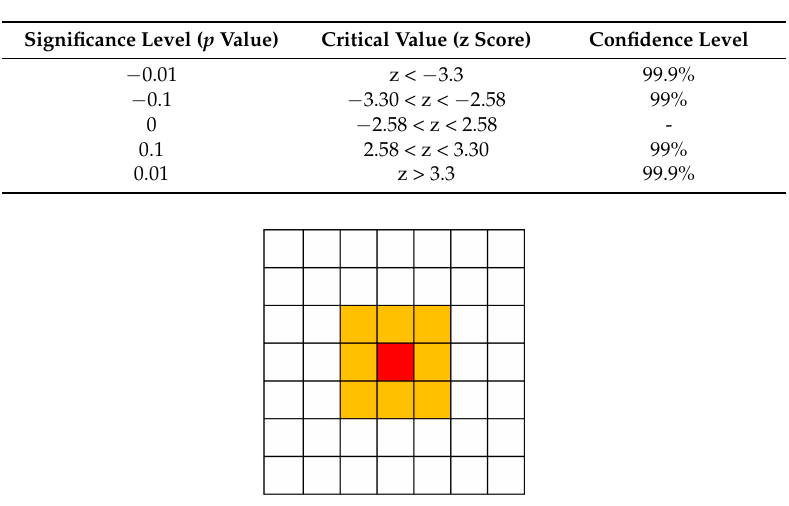
Figure 2. The calculation of the local LST sum for a pixel under consideration (red) includes all of its neighbors (orange).